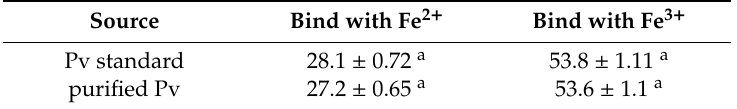
Table 8. The Pv standard and purified Pv with Iron-binding ability.